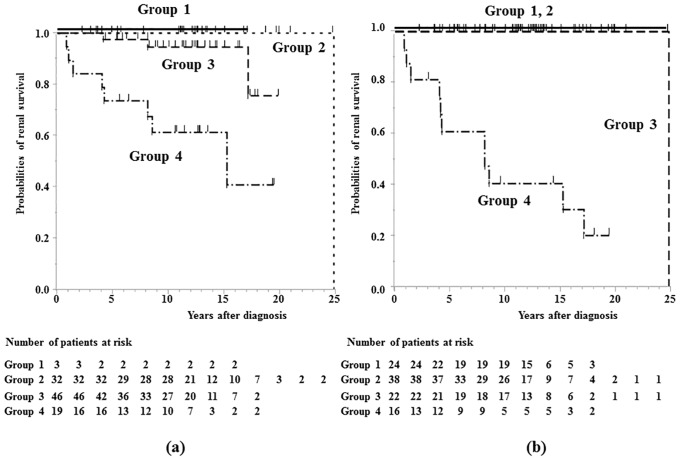
Survival curve showing time to ESKD.a) Kaplan-Meier plot showing time to ESKD stratified by proteinuria at diagnosis. b) Kaplan-Meier plot showing time to ESKD stratified by proteinuria during follow-up period. group 1, no proteinuria (<0.2 g/day/1.73 m2); group 2, mild proteinuria (0.2–1.0 g/day/1.73 m2); group 3, heavy proteinuria without hypoalbuminemia (>1.0 g/day/1.73 m2 with serum albumin level ≥3.0 g/dL); group 4, heavy proteinuria with hypoalbuminemia (>1.0 g/day/1.73 m2 with serum albumin level <3.0 g/dL).